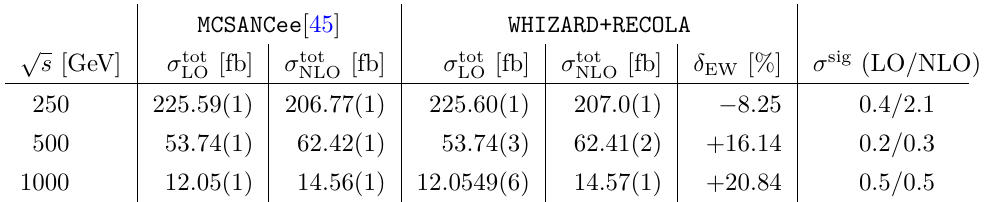
Table 7 . Comparison of LO and NLO total inclusive cross sections results of the MCSANCee and WHIZARD+RECOLA setup for the unpolarized process e + e − → HZ